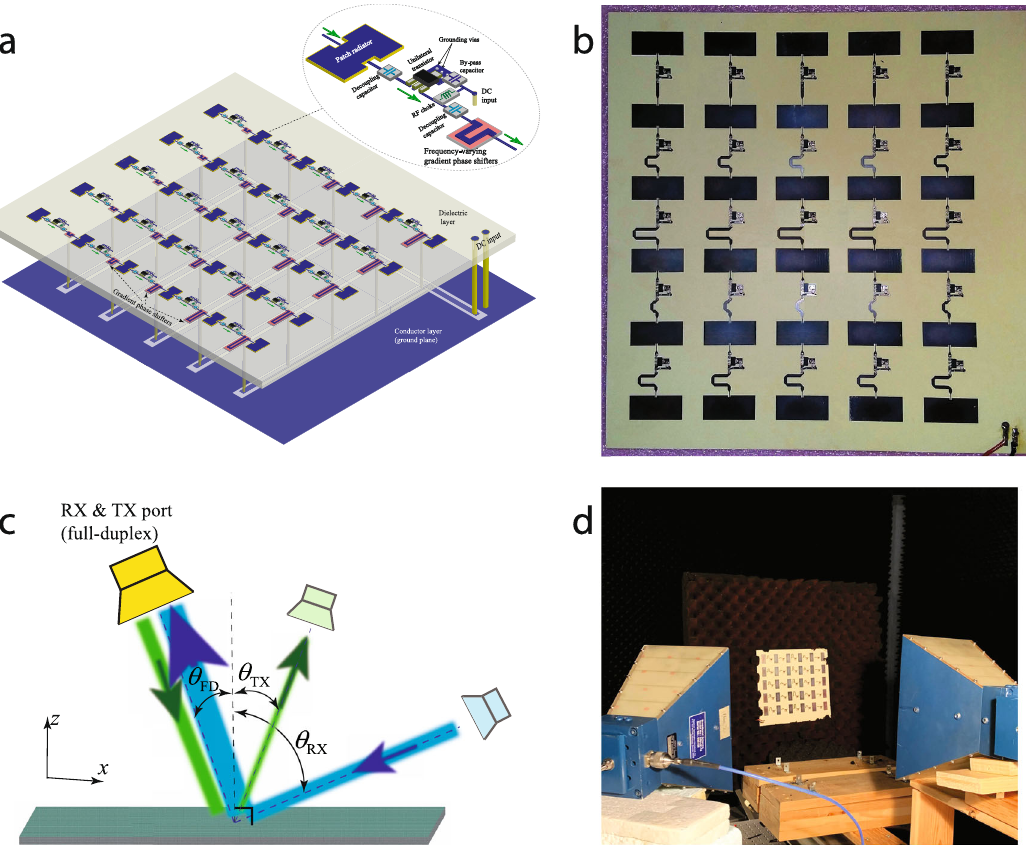
Fig. 5 Experimental demonstration. a Architecture of the fabricated re fl ective beamsteering metasurface. b A photo of the fabricated metasurface. c , d Measurement set-up.